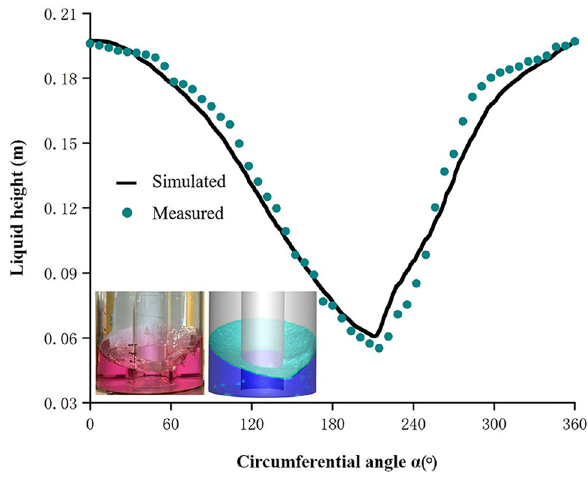
Figure 3. The liquid level of simulation and experiment was compared. The simulation and experimental results of the hollow OSR with filling volume of 8 L and shaking speed of 100 rpm under h L = 0 mm were compared. To see the liquid more clearly, a certain amount of Methyl Red and hydrochloric acid was added before performing the capturing experiment. The solid black line and the green point represent the liquid wave height measured by simulation and experiment respectively. The circular angle ( α ) represented the angle of the wall of the hollow OSR in the cylindrical coordinate system.